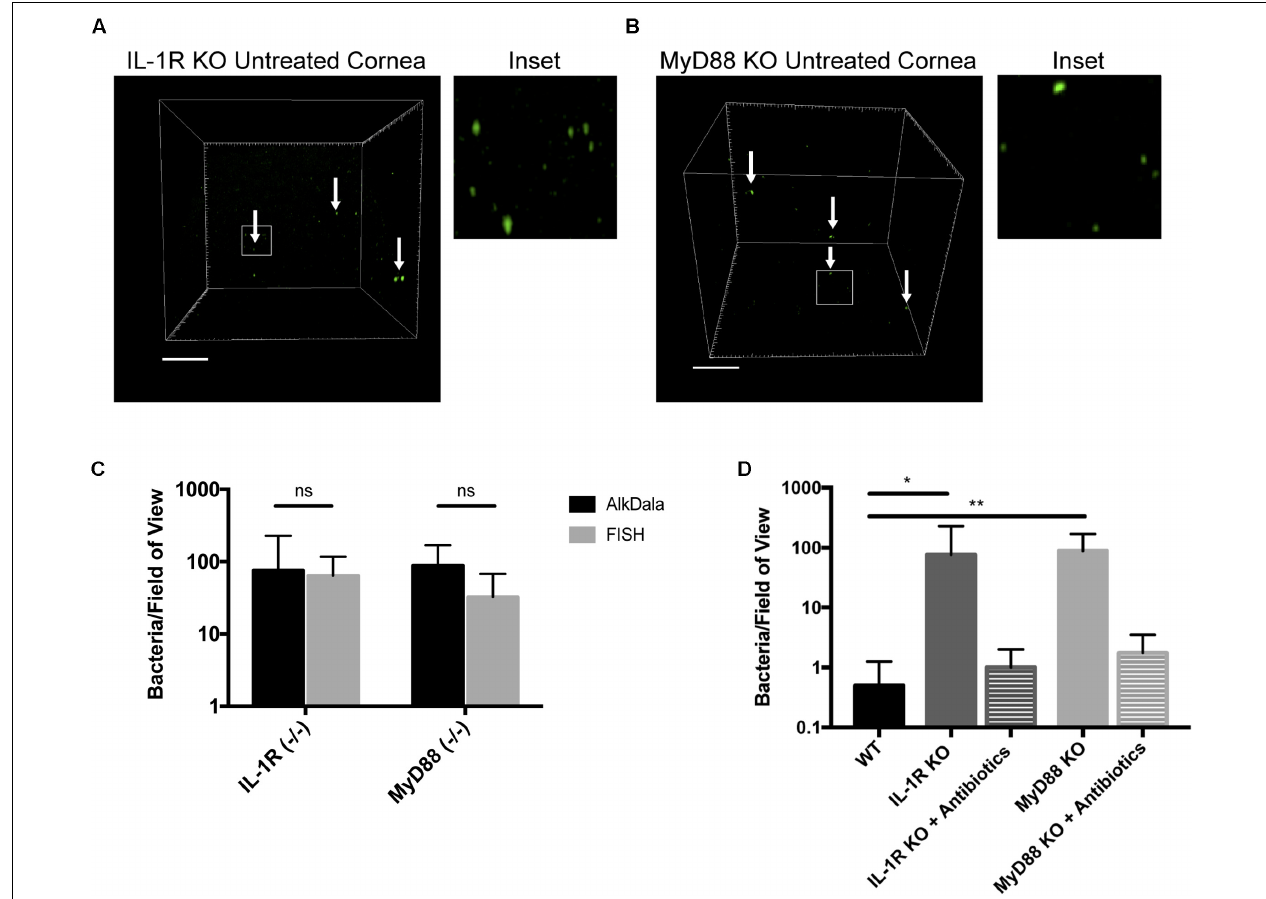
FIGURE 7 | Corneas of IL-1R (–/–) and MyD88 (–/–) C57BL/6 mice harbor significantly more viable bacteria than wild-type. (A) AlkDala-labeling revealed many metabolically active bacteria (white arrows) on the corneas of uninjured IL-1R (–/–) mice. A representative field of view is shown from seven different corneas (three male and four female mice). (B) MyD88 (–/–) mouse corneas were also colonized with metabolically active bacteria. A representative field of view is shown from six different corneas (two male and four female mice). (C) AlkDala and FISH detected similar numbers of viable bacteria on Il-1R (–/–) or MyD88 (–/–) corneas (ns, not significant, Mann–Whitney U -test). (D) Quantification of viable bacteria detected per field of view using alkDala. Mean ± SD viable bacteria on the murine cornea was significantly higher in IL-1R (–/–) and MyD88 (–/–) mice versus wild-type, ∗ P < 0.05, ∗∗ P < 0.01 (Kruskal–Wallis test with Dunn’s multiple comparison).